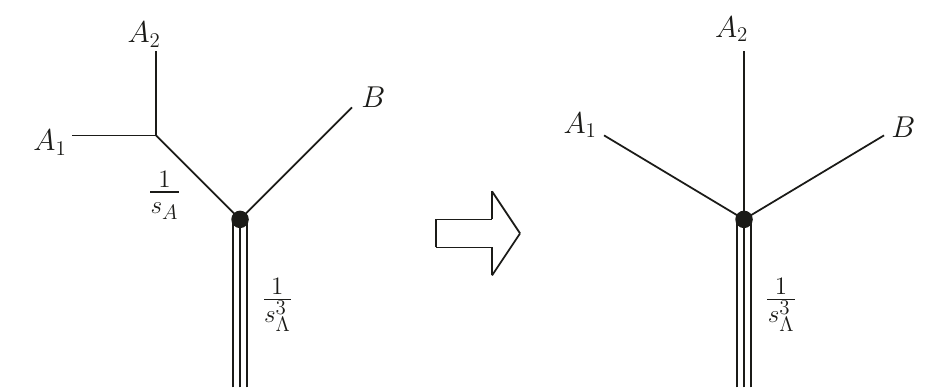
Figure 3. Creation of the quartic vertex from a cubic